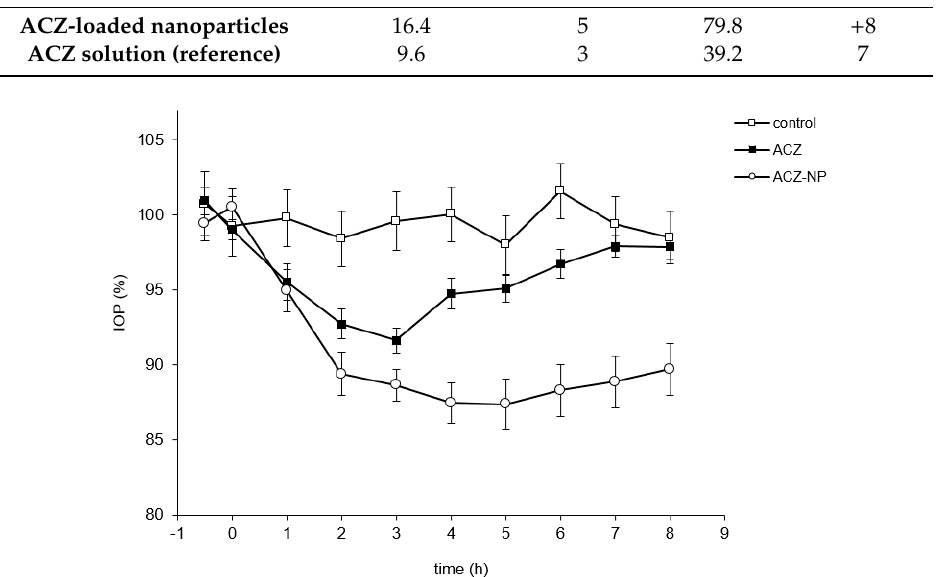
Table 1. The IOP parameters used in the evaluation of in vivo e ffi cacy of ACZ formulations after a single administration (25 µ l, 20 µ g ACZ). IOP, intraocular pressure; maximum IOP reduction (%), time of maximum e ff ect, area under the curve from 0 to 8 h, and duration of e ff ect ( n = 20 eyes). Formulation ∆ IOPmax (%)